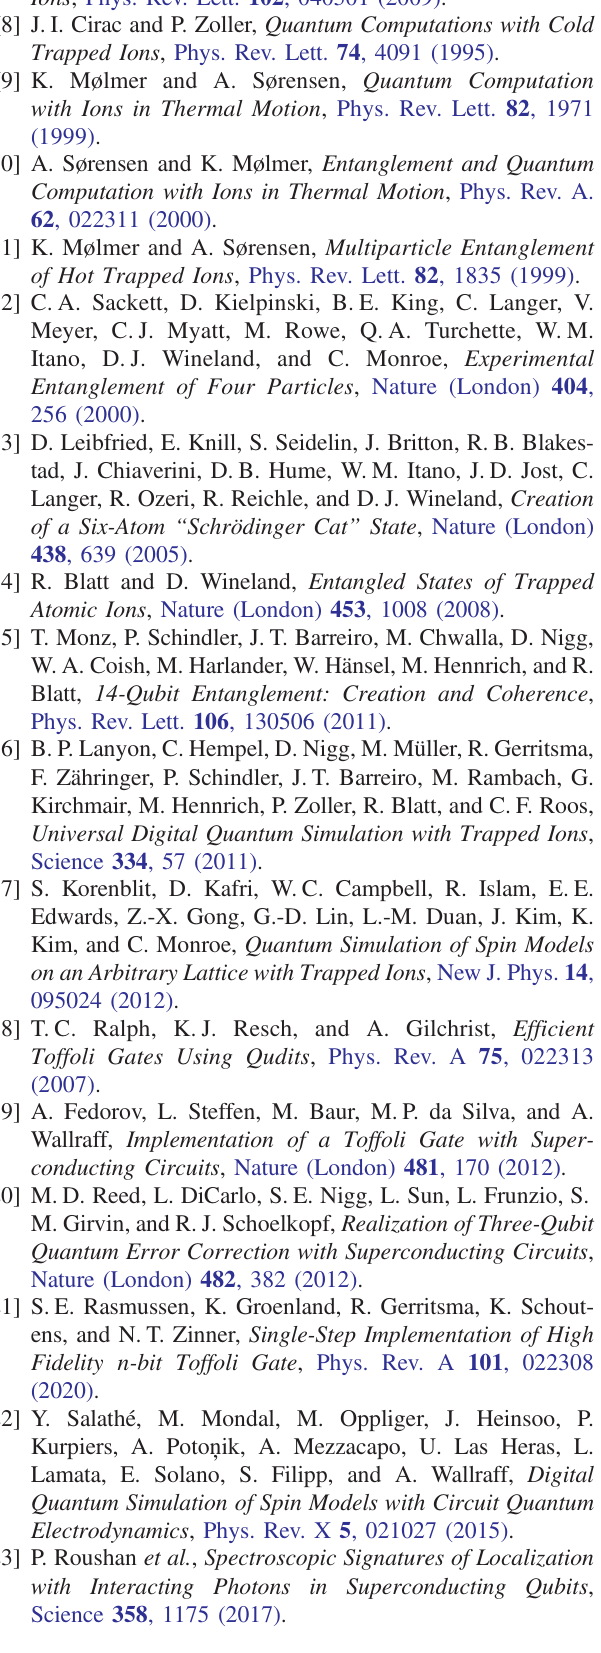
Figs. 2(a), 5(c), and 5(d), the average error due to non- adiabatic transitions for a Gaussian excitation pulse is estimated by Eq. (7) for both the Toffoli and fan-out gates.